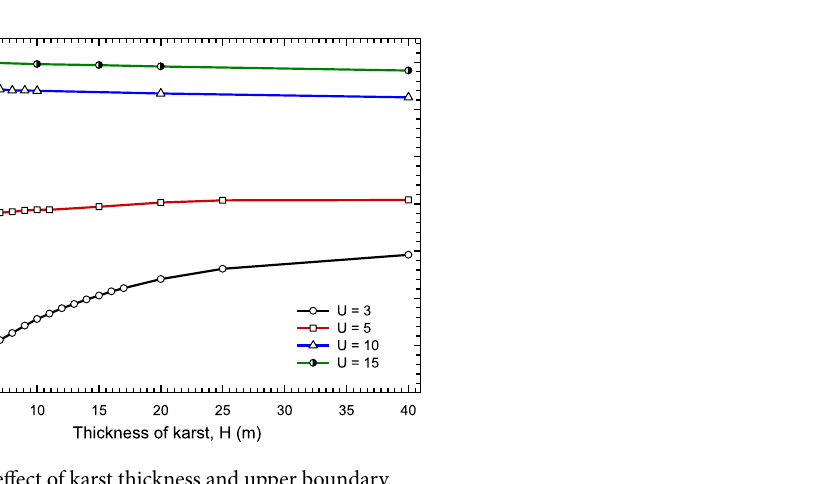
Figure 14. The effect of karst thickness and upper